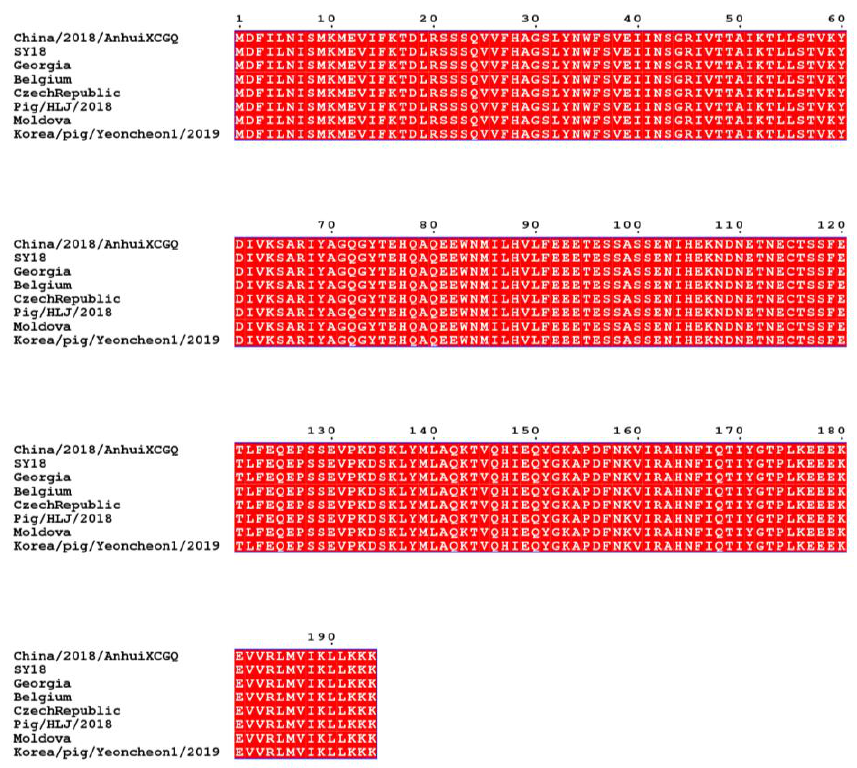
Figure 2. Comparison of CP204L sequences of different virulent strains.